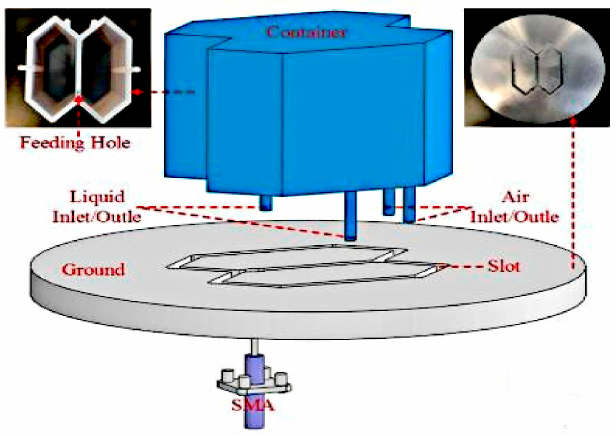
Figure 35. Liquid dielectric resonator antenna (DRA) [61].